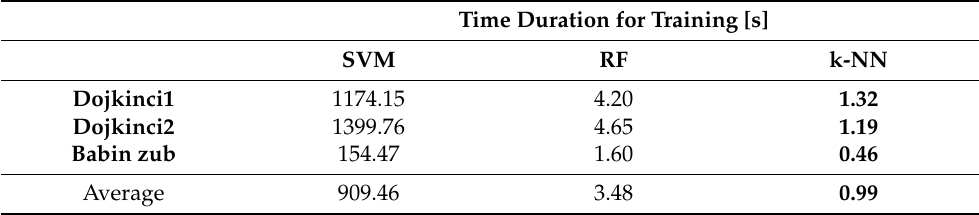
Table 5. Time duration for training vector